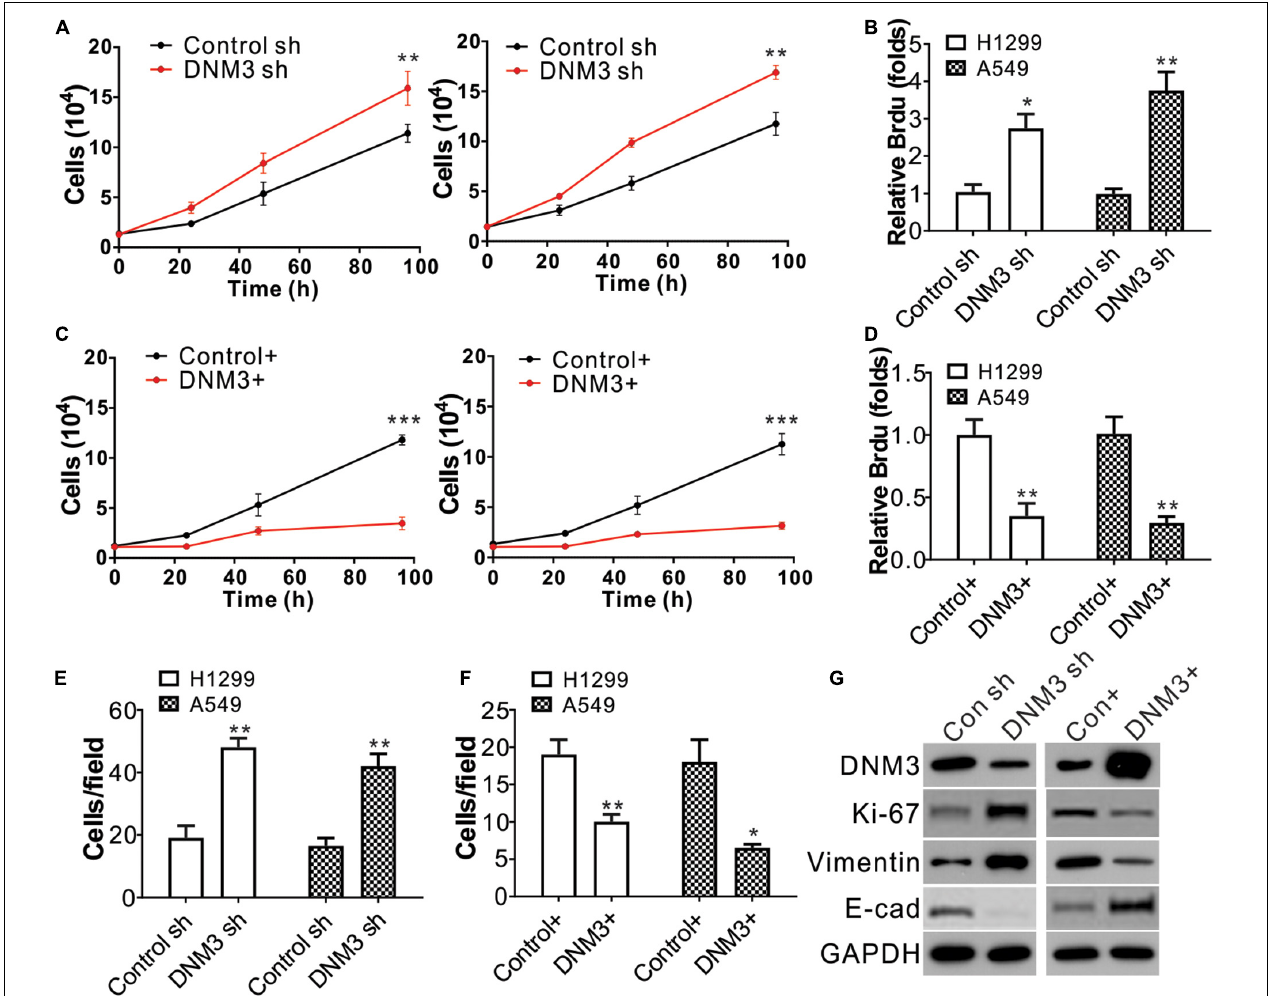
FIGURE 2 | The knockdown of DNM3 promotes lung cancer cell proliferation and migration in vitro . (A) MTS assay of the growth of H1299 (left) and A549 (right) cells with or without DNM3 shRNA transfection. (B) Brdu assay of the proliferation of H1299 and A549 cells with or without DNM3 shRNA transfection. (C) MTS assay of the growth of H1299 (left) and A549 (right) cells with or without DNM3 overexpression. (D) Brdu assay of the proliferation of H1299 and A549 cells with or without DNM3 overexpression. (E) Transwell assay of the migration of H1299 and A549 cells with or without DNM3 shRNA transfection. (F) Transwell assay of the migration of H1299 and A549 cells with or without DNM3 overexpression. (G) Expression of the indicated proteins in H1299 cells with DNM3 shRNA transfection (left) or DNM3 overexpression (right). Each experiment was repeated 3 times. * p < 0.05; ** p < 0.01; *** p <